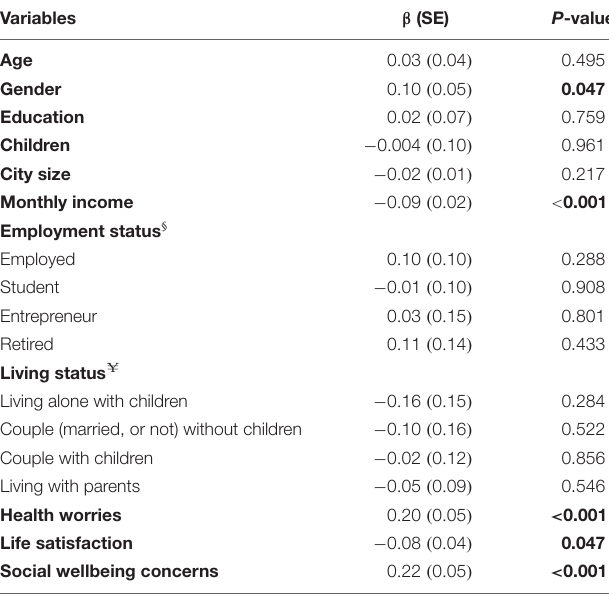
TABLE 3 | Differences in economic worries between men and women across demographics. Women Men